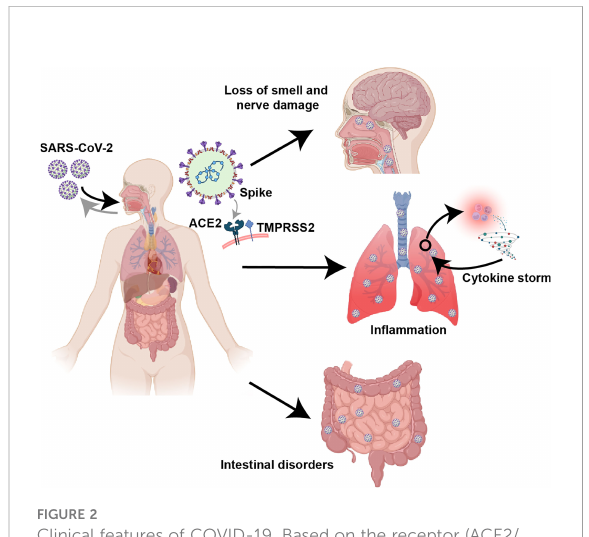
FIGURE 2 Clinical features of COVID-19. Based on the receptor (ACE2/ TMPRSS2) binding speci fi city of the Spike protein, SARS-CoV-2 can infect multiple tissues and organs, especially the respiratory tract, lung and intestine. COVID-19 can cause signi fi cant lung in fl ammation, intestinal disturbances, and nerve damage, including loss of